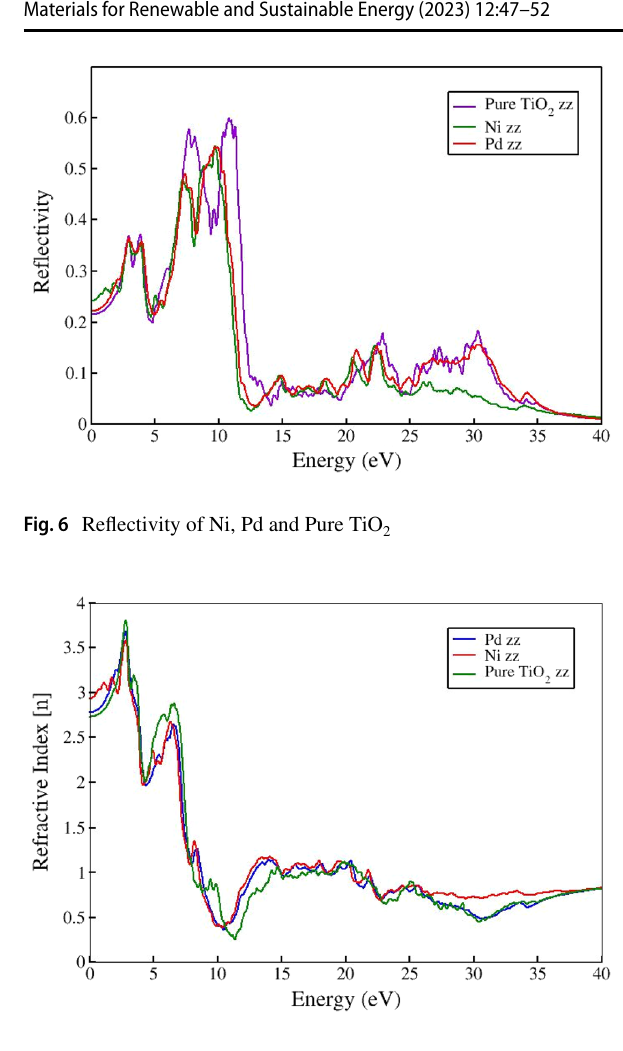
Fig. 7 Refractive Index of Ni, Pd and Pure TiO